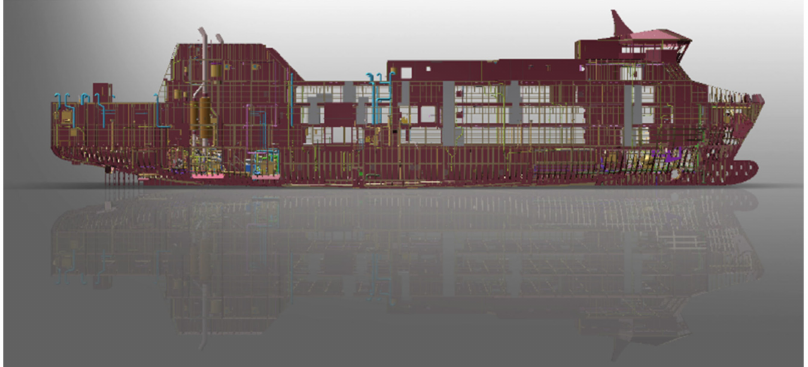
Figure 4. 3D ship model representation including internal structure and outfitting